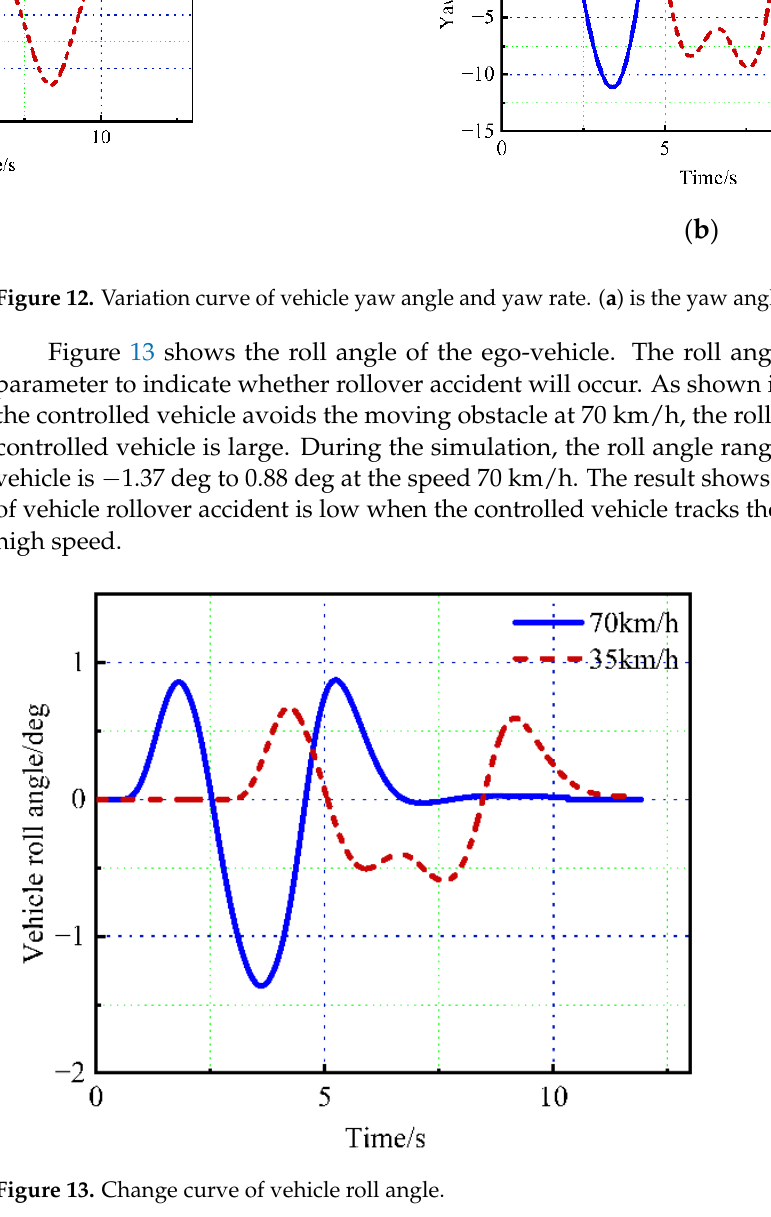
Figure 12. Variation curve of vehicle yaw angle and yaw rate. ( a ) is the yaw angle, ( b ) is the yaw rate.